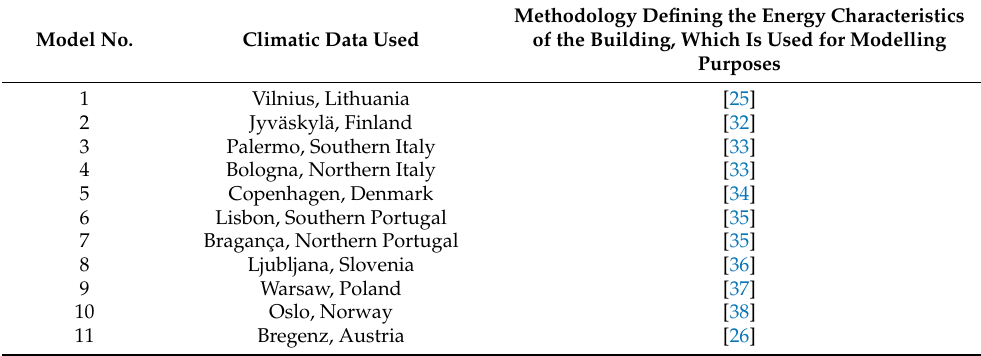
Table 7. Summary of study